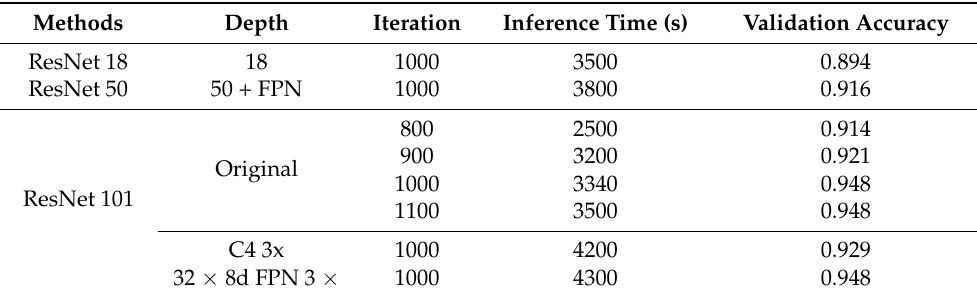
Table 7. A comparison of the different ResNet backbones for Detectron-2. Methods